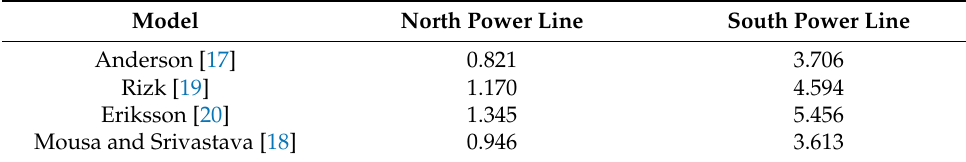
Table 4. The estimated flash incidence to a power line according to different